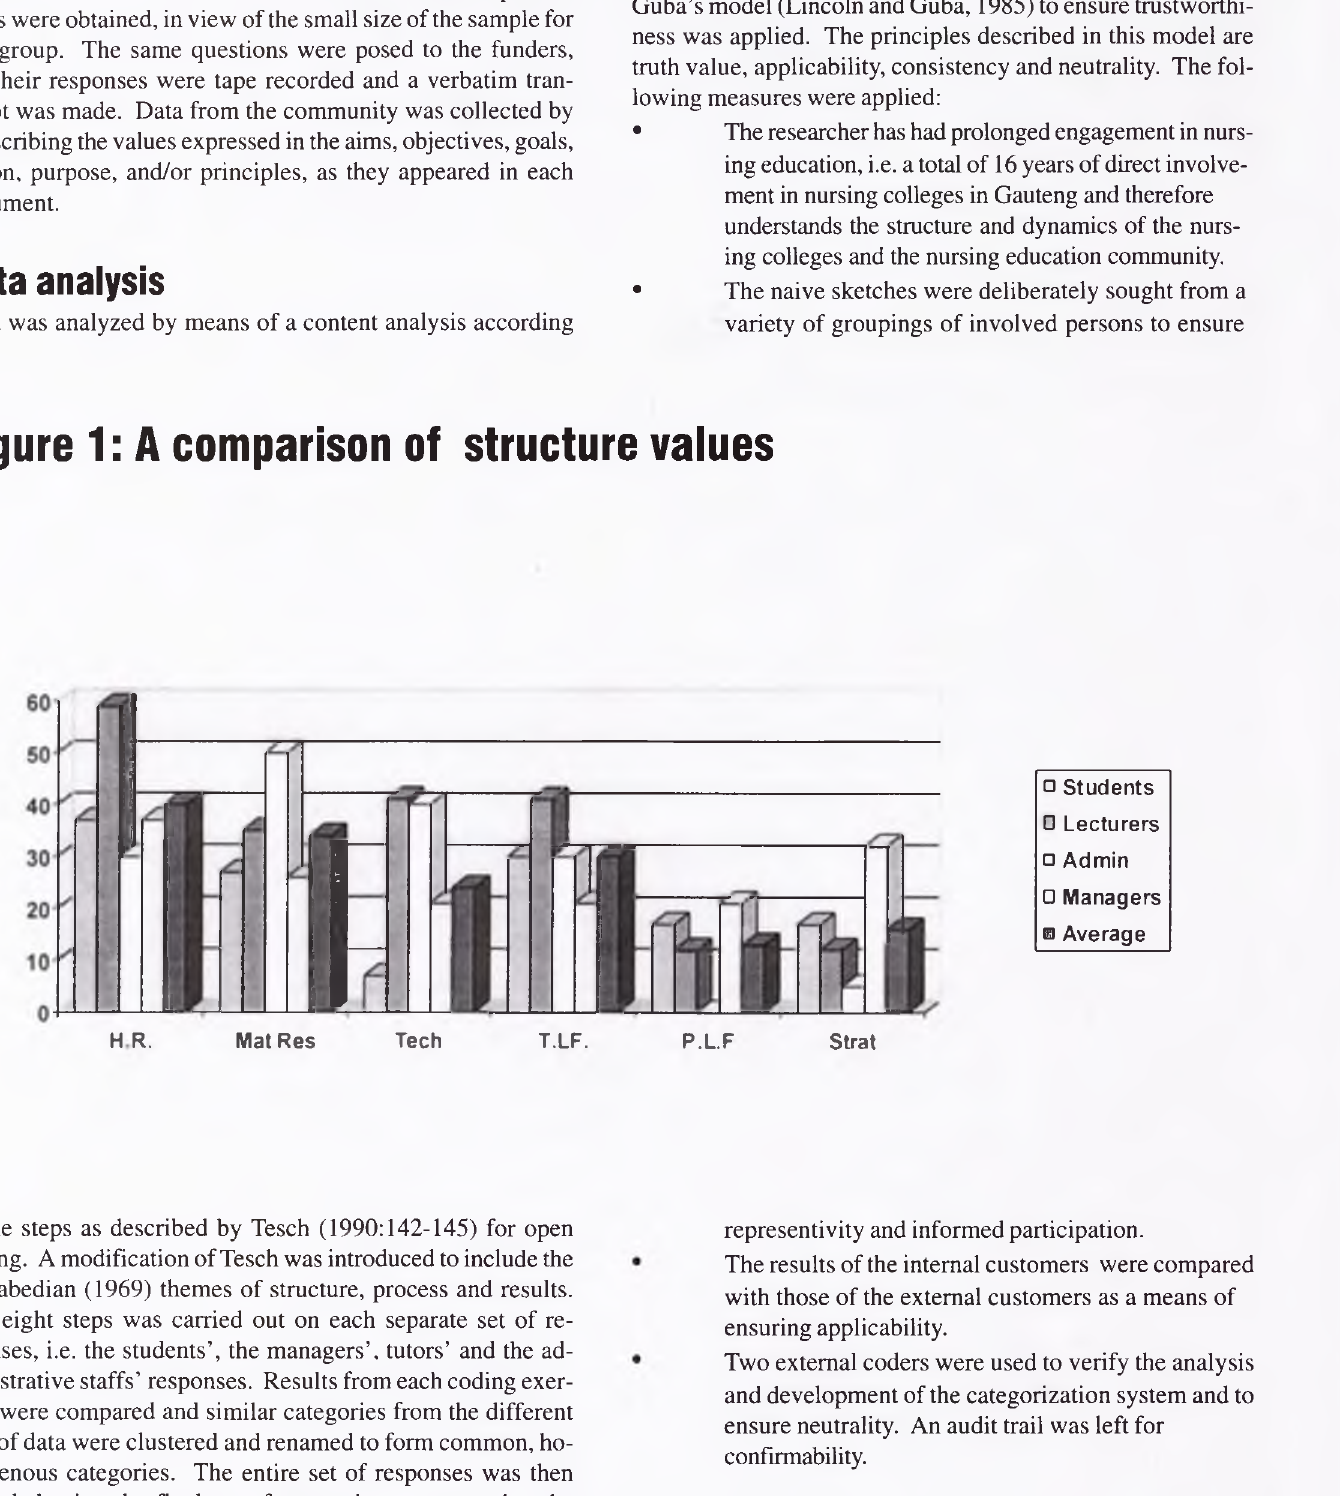
□ Students □ Lecturers □